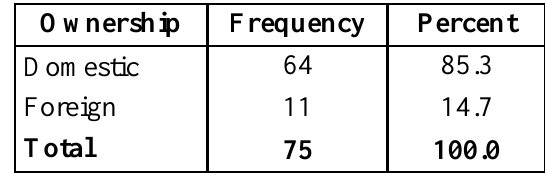
Table 2: Hotel Ownership